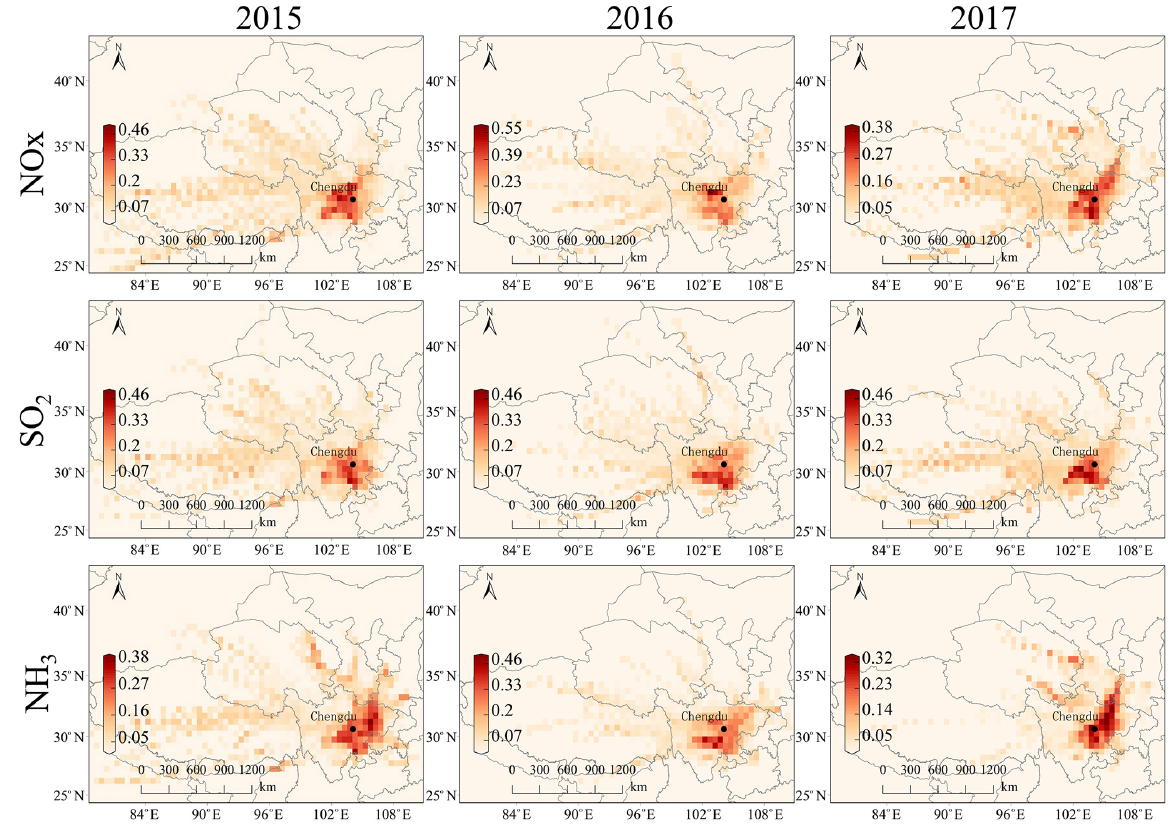
Figure 9. PSCF (potential source contribution function) of NO x , SO 2 and NH 3 in Chengdu from 2015 to